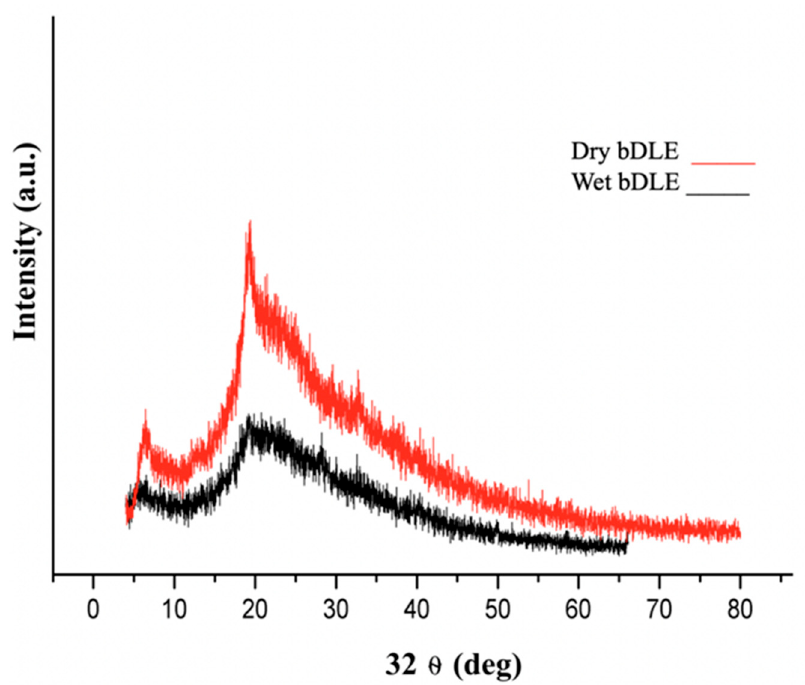
Figure 2. X-ray diffraction pattern of wet and dry bDLE. X-ray diffractogram of wet (black) and dry (red) bDLE.